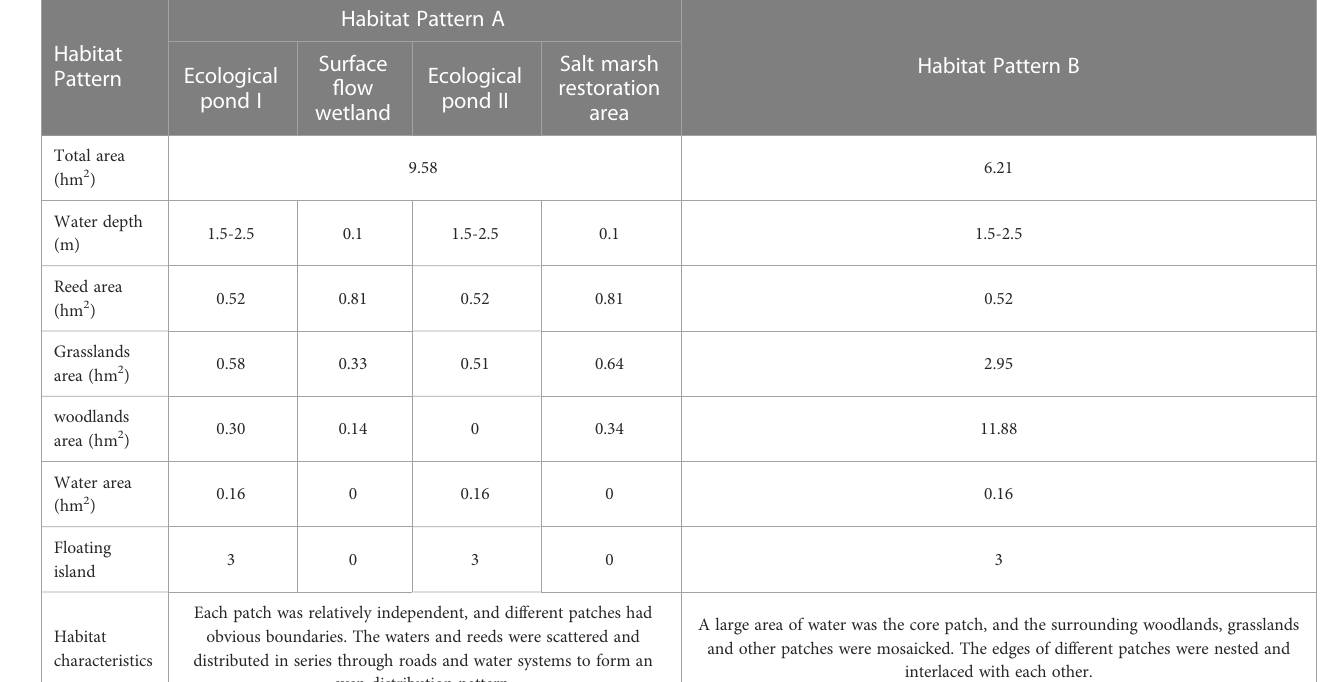
TABLE 1 Location of the Study Area and Habitat Pattern Zoning.